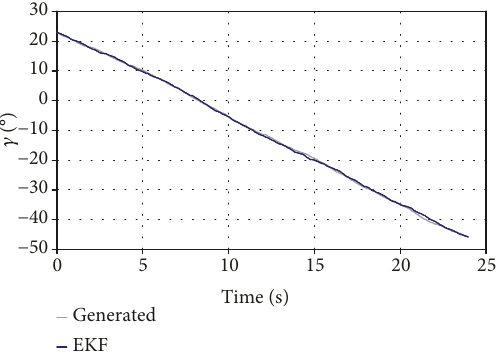
Figure 9: Simulated and estimated pitch angle of ICP-89.